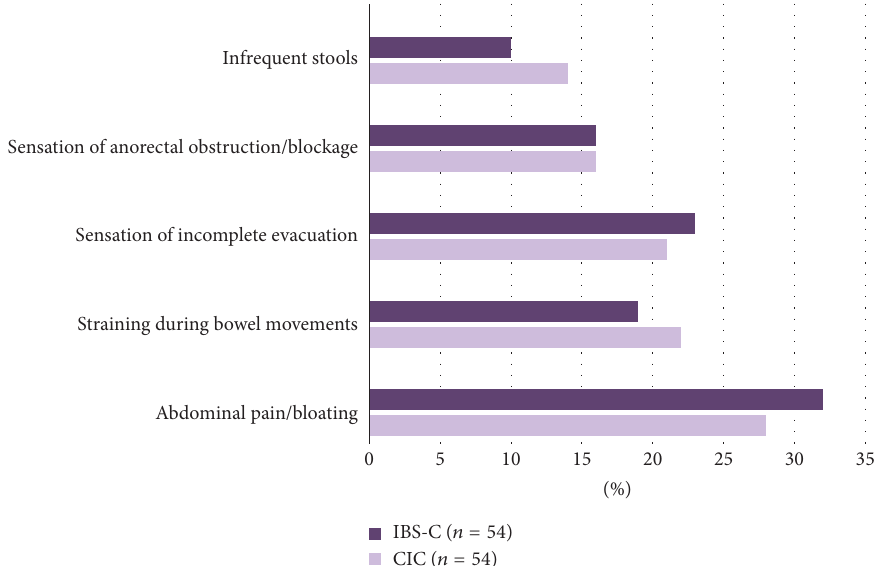
Figure 3: Respondents’ perceptions of symptoms that most affect patients’ quality of life based on the type of constipation. Abdominal pain/bloating was ranked as being the most burdensome symptom in both CIC (28%) and IBS-C (32%). (CIC : chronic idiopathic constipation; IBS-C : constipation-predominant irritable bowel syndrome)